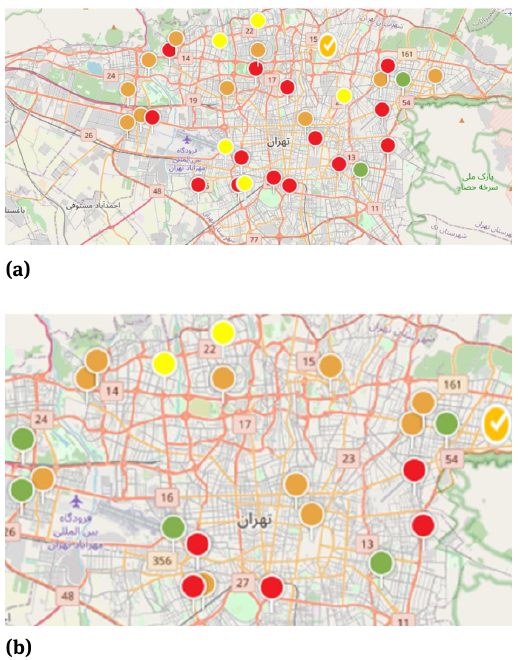
Figure 12: Online monitoring of airborne noise pollution in Tehran using information of fixed noise measuring stations at different times [45], (a) 8 a.m., (b) 11 a.m. and (c) SPL variation.